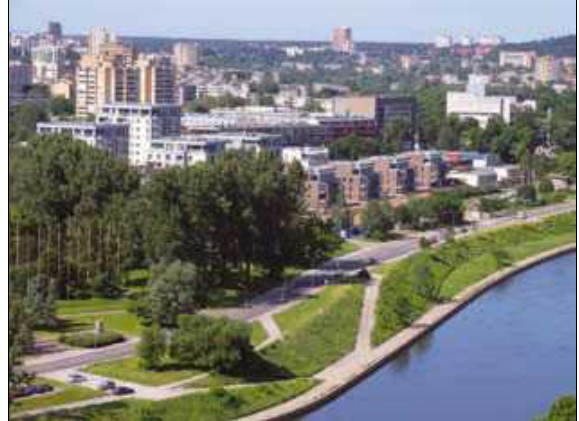
18 pav. Gyvenamasis kvartalas r­aitininkų g. (archit. G. Čaikau­skas, V. Venckūnienė, J. Striu­kienė, P. Petku­s) Fig. 18. blocks of flats in r­aitininkai st. a­rch. G. Čaikau­skas, V. Venckūnienė, J. Striu­kienė, P. Petku­s